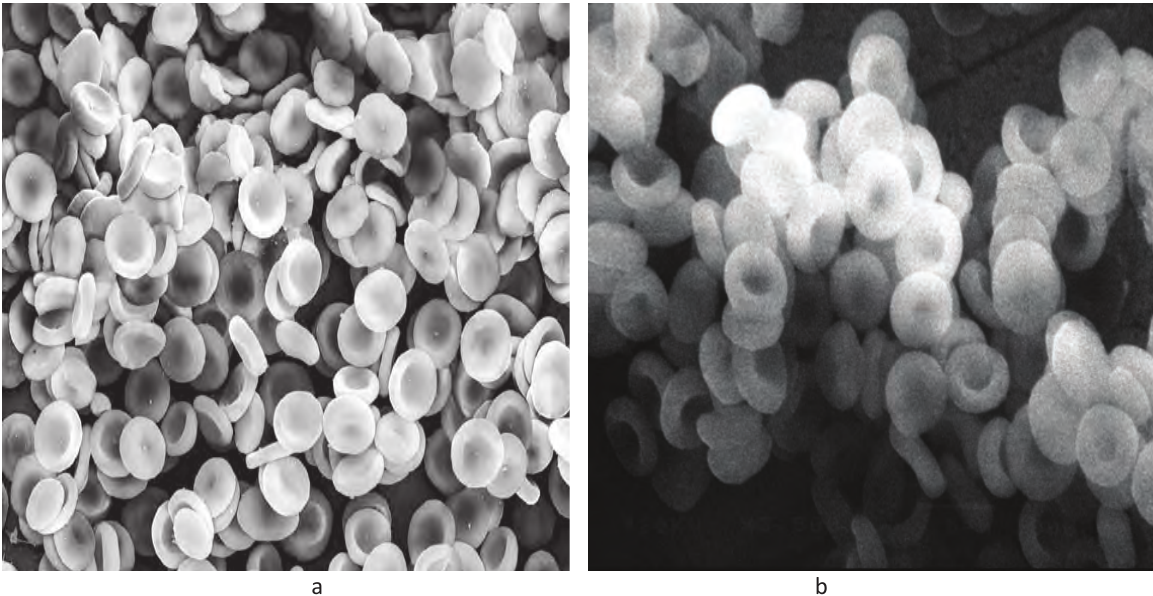
a Fig. 2. The structure of periphery blood erythrocytes of 2 nd group’s volleyball players with eukinetic blood circulation type after single maximal physical load. The method is – scanning electronic microscopy, scale: a -1400:1 and b - 1500:1.